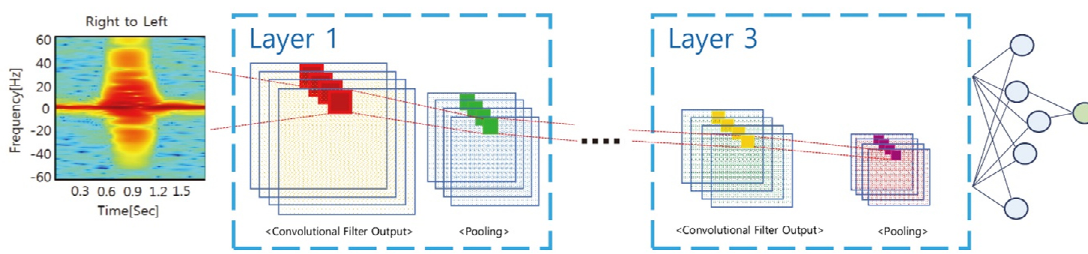
Figure 7. Structure in convolutional neural network (CNN) with three layers.